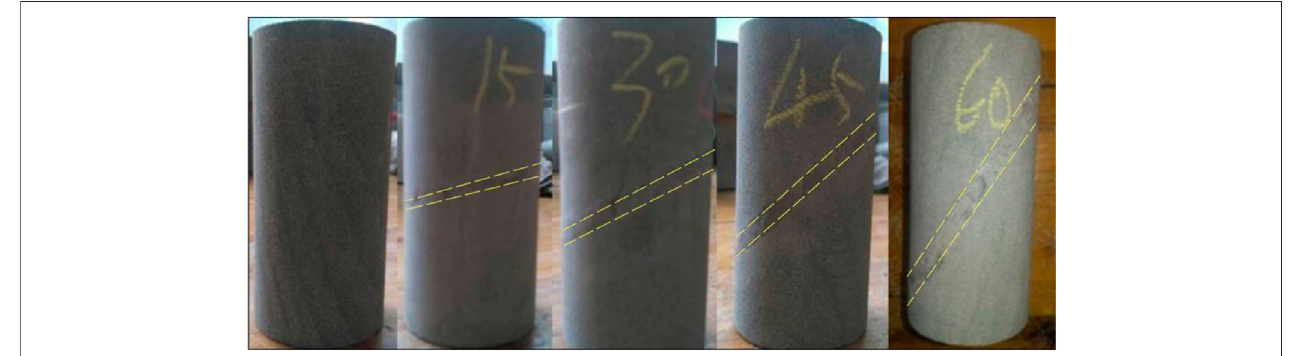
FIGURE 3 | The prepared specimens (a part of) used in the conventional uniaxial and triaxial compression test and creep test.